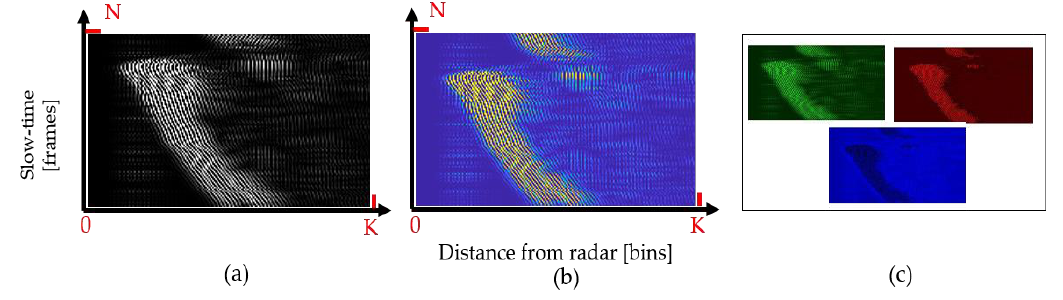
Figure 6. Red, green, and blue (RGB) signal formation for 5.5 s of gesture: ( a ) grayscale radar data; ( b ) corresponding colored image; ( c ) R, G, and B channels of the image in ( b ).